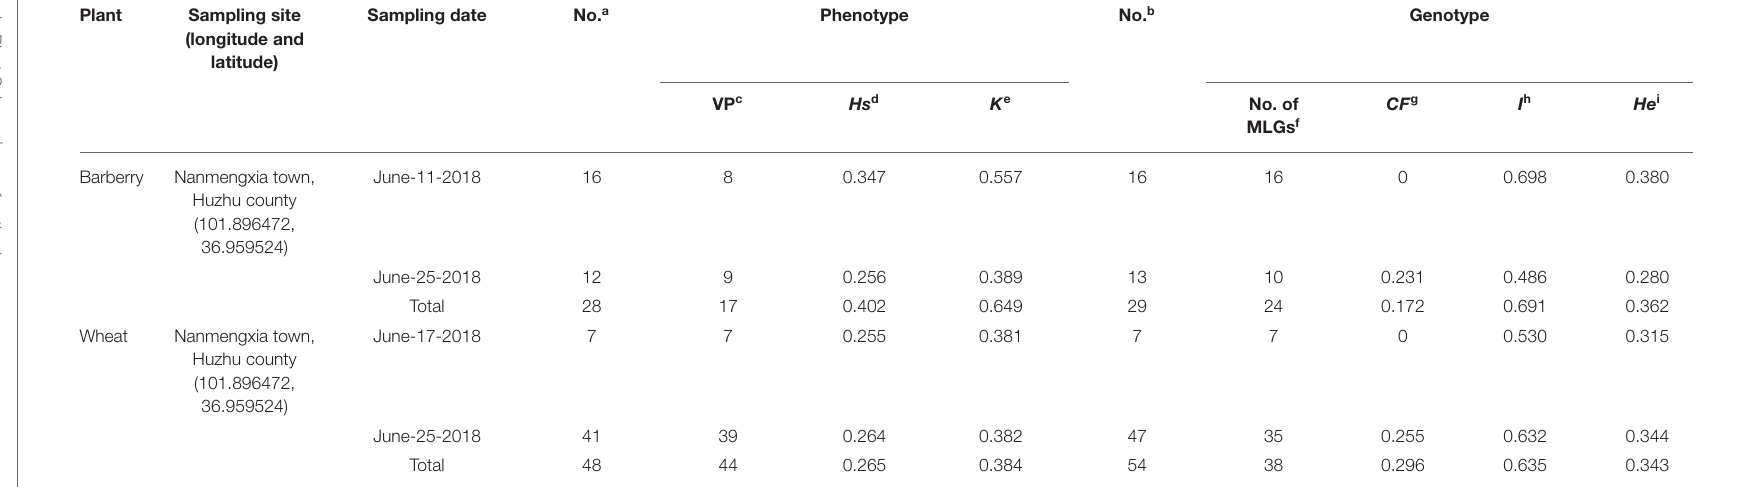
TABLE 1 | Population genetic data of Puccinia striiformis f. sp. tritici isolates from barberry bushes and wheat plants in Nanmengxia, Huzhu, Qinghai. Sampling date No. a No. b Plant Sampling site (longitude and latitude)